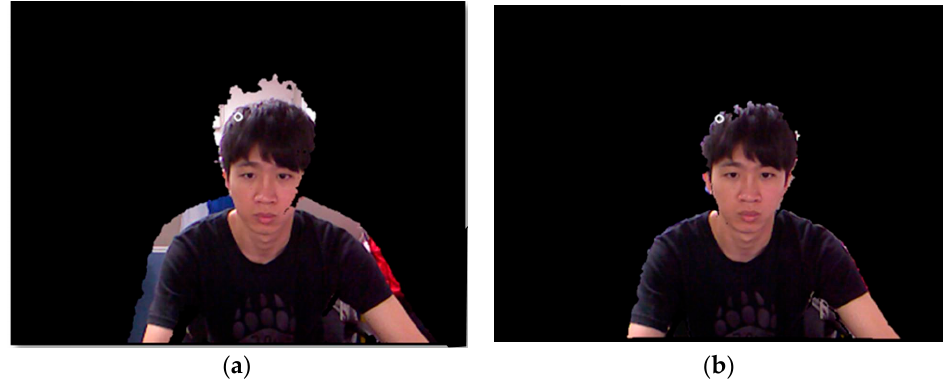
Figure 3. Calibration process to adjust the color and depth features to be coherent: ( a ) before adjustment and ( b ) after adjustment.